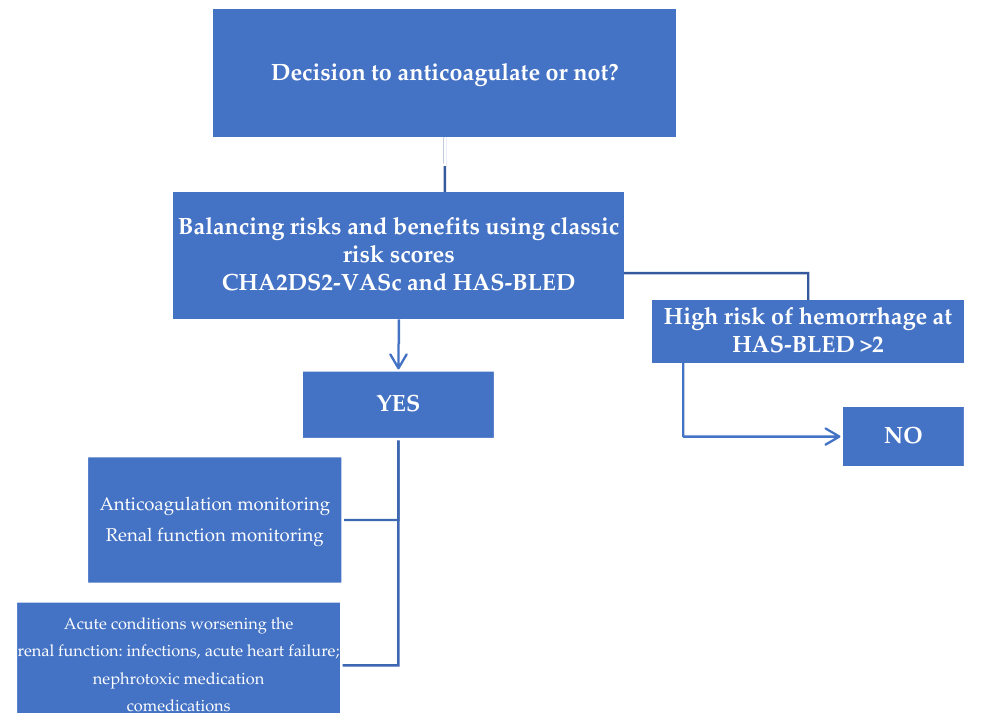
Figure 2. Individualized approach for decision to anticoagulate or not in patients with AF and advanced CKD.